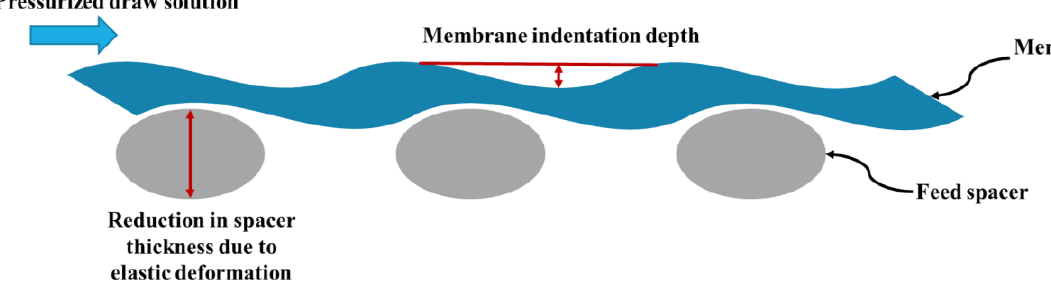
Figure 9. Effect of the draw solution ’s high pressure on the feed channel hydrodynamics.